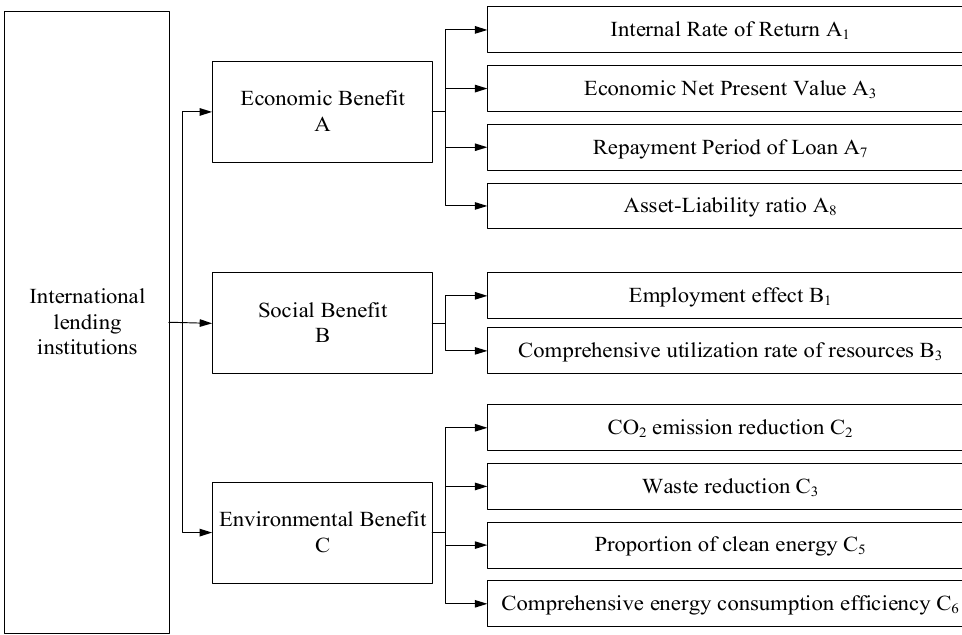
Figure 3. The comprehensive benefits evaluation index system of transnational power networking projects based on the perspective of international lending